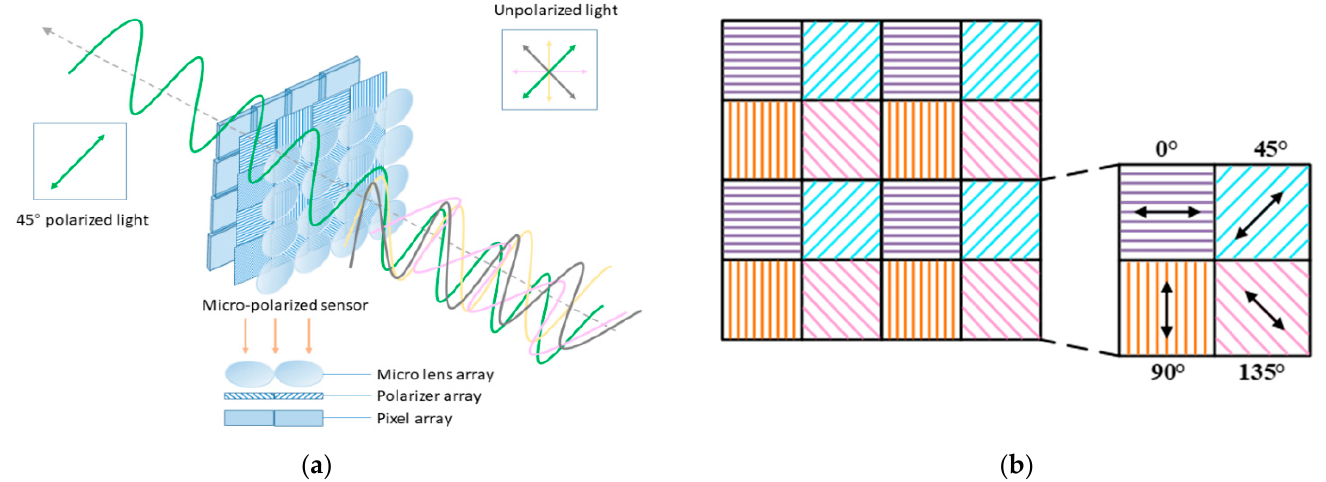
Figure 2. Pixel-level polarization sensor. ( a ) principle and the layered structure within sensor. ( b ) one example of micro-polarization-pixel arrays.